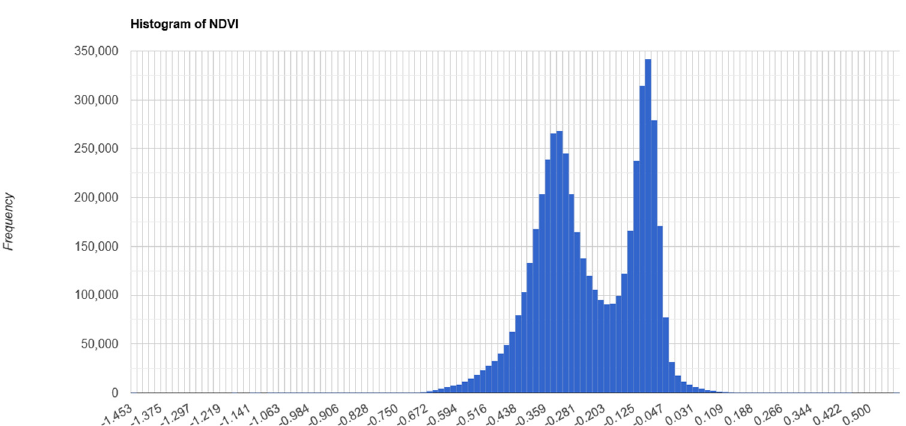
Figure 7. Bimodal distribution of NDVI change image showing two distinct pixel groups: flooded and non-flooded pixels.